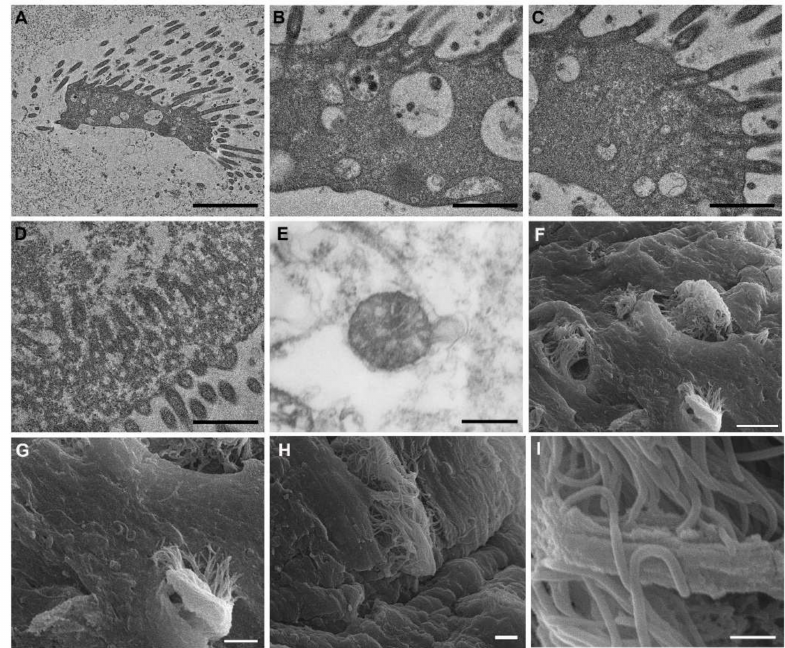
Figure 4. Electron microscopy analyses. ( A – E ) Transmission electron microscopy of the pathogen. In cyst mucus, numerous protist-like cells ( A ) with long undulipodia were found. At higher magnifica- tion ( B ), electron dense and transparent vacuoles were observed as well as undulipodium rootlets regularly distributed along cytoplasm periphery ( C , D ). Mitochondria with peculiar cristae were detected ( E ). ( F – I ) Scanning electron microscopy. Trapped inside mucus niches, protist-like cells were observed ( F , G ). Their main feature was the numerous and long cilia/undulipodia which covered the cell membrane ( H , I ). Scale bars: ( A ) 2 µ m; ( B – D ) 1 µ m; ( E ) 500 nm; ( F ) 10 µ m; ( G ) 5 µ m; ( H ) 2 µ m; ( I ) 1 µ